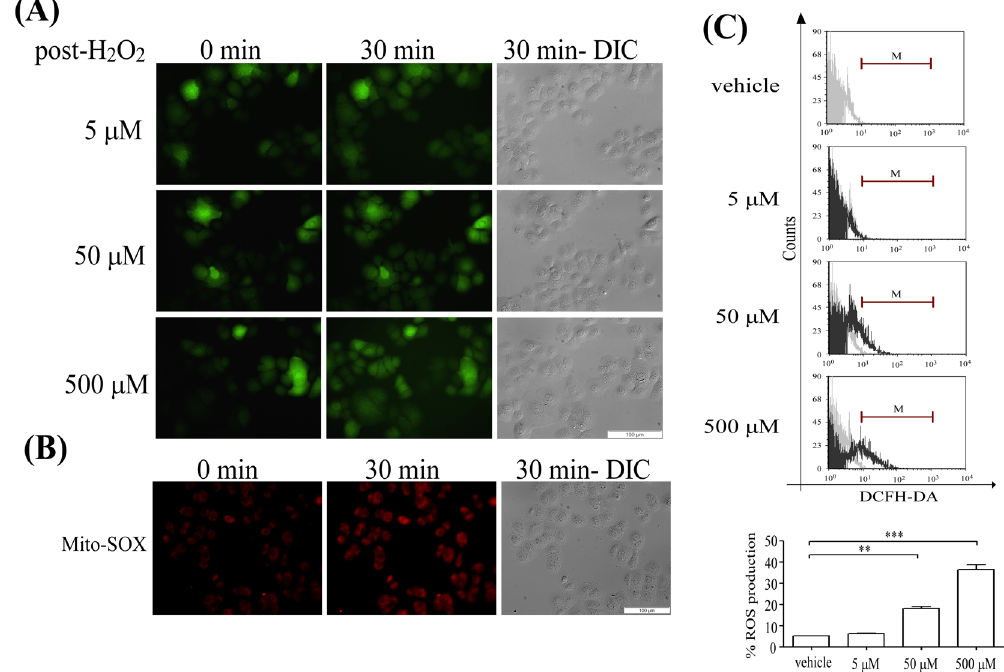
Figure 1. H 2 O 2 dose-dependently induced oxidative stress in KC. ROS generation was stimulated by 5 μ M, 50 μ M, and 500 μ M H 2 O 2 for 30 min at 37 °C in humidified 5% CO 2 and visualized using DCFH-DA or MitoSOX pre-staining. ROS are indicated by the fluorescent signals of ( A ) DCFH-DA or ( B ) MitoSOX, and cell morphology is shown using differential interference contrast (DIC) microscopy. Scale bars in A and B = 100 µ m. ( C ) Quantification of ROS production from ( A ) was analyzed using flow cytometry after incubation with H 2 O 2 . Each group (black line) was compared with vehicle (gray line) and ROS production was quantified (lower panel) by adding all black area and subtracting all gray area within the period marked by the red line “M”, using FCS Express 4 Image Cytometry Software (De Novo Software) ( ** P < 0.01; *** P <